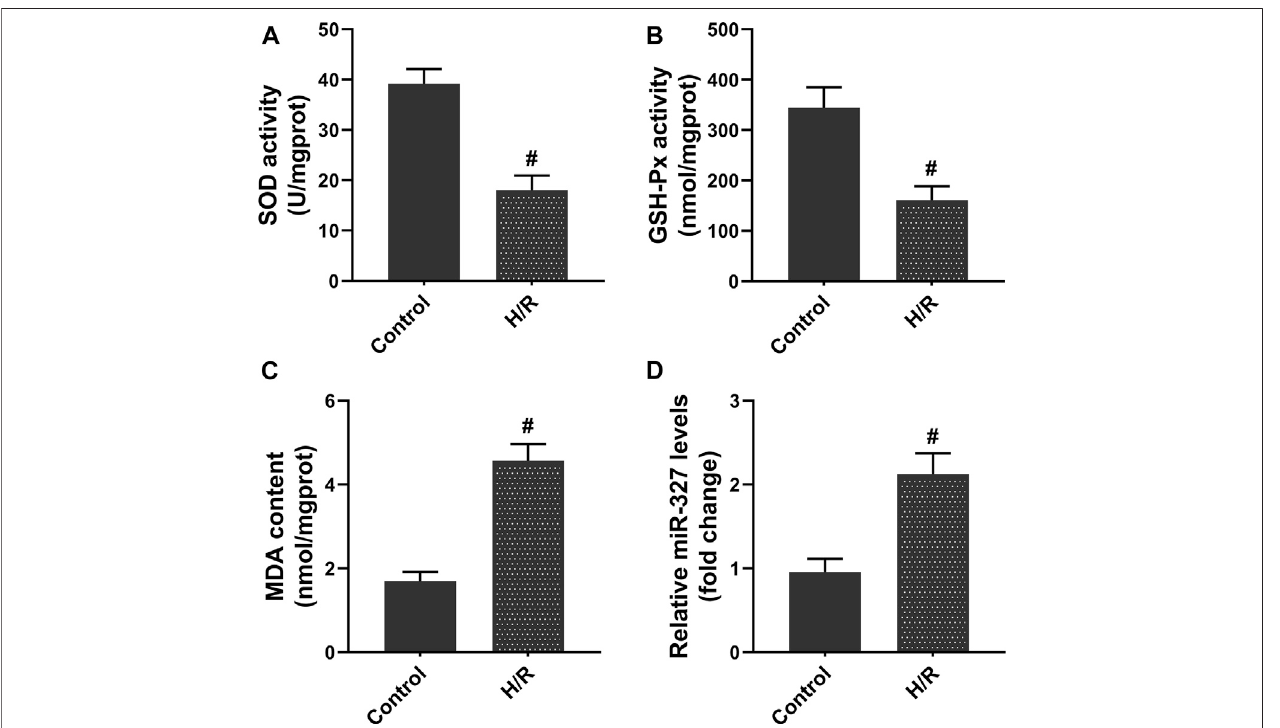
FIGURE 1 | H/R induced oxidative stress, and the expression of miR-327 was upregulated in H9c2 cells. The cellular redox state in H/R H9c2 cells was assessed by SOD (A) , GSH-Px (B) activities, and MDA (C) content. (D) Relative expression of miR-327 in H/R H9c2 cells. Data are expressed as the mean ± SD; n (cid:2) 3; # p < 0.05 compared to the Control